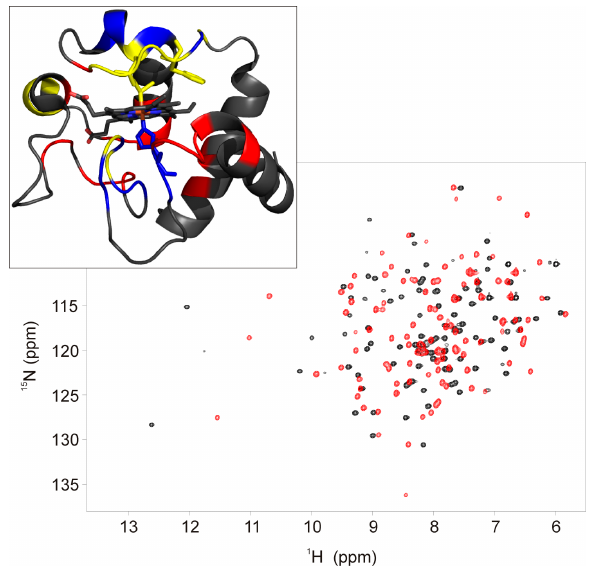
Figure 3. Overlay of the 1 H- 15 N HSQC spectra of the ferric form of F82K (black trace) and wild type (red trace) human cyt c. Spectra were acquired at 800 MHz and 280 K in 20 mM phosphate buffer, pH 6.8. Residues of F82K showing chemical shift perturbation of the amide protons > 0.4 ppm and < − 0.4 ppm with respect to the wild type cyt c are highlighted on the protein surface in blue and red, respectively (PDB id: 1J3S) (upper panel). Residues whose amide protons are not assigned are highlighted in yellow.